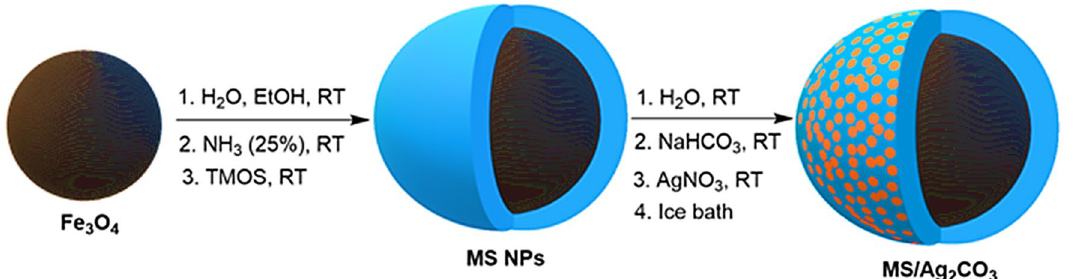
Figure 1. Preparation of the MS/Ag 2 CO 3 nanocomposite.